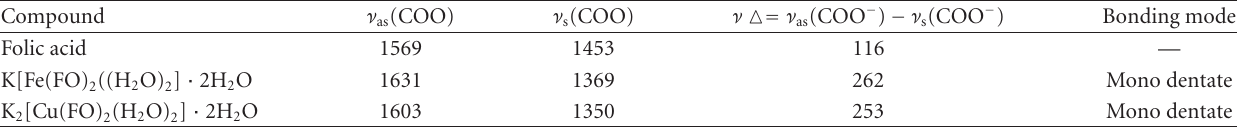
Table 3: Asymmetric and Symmetric Stretching Vibrations of the Carboxylate group.